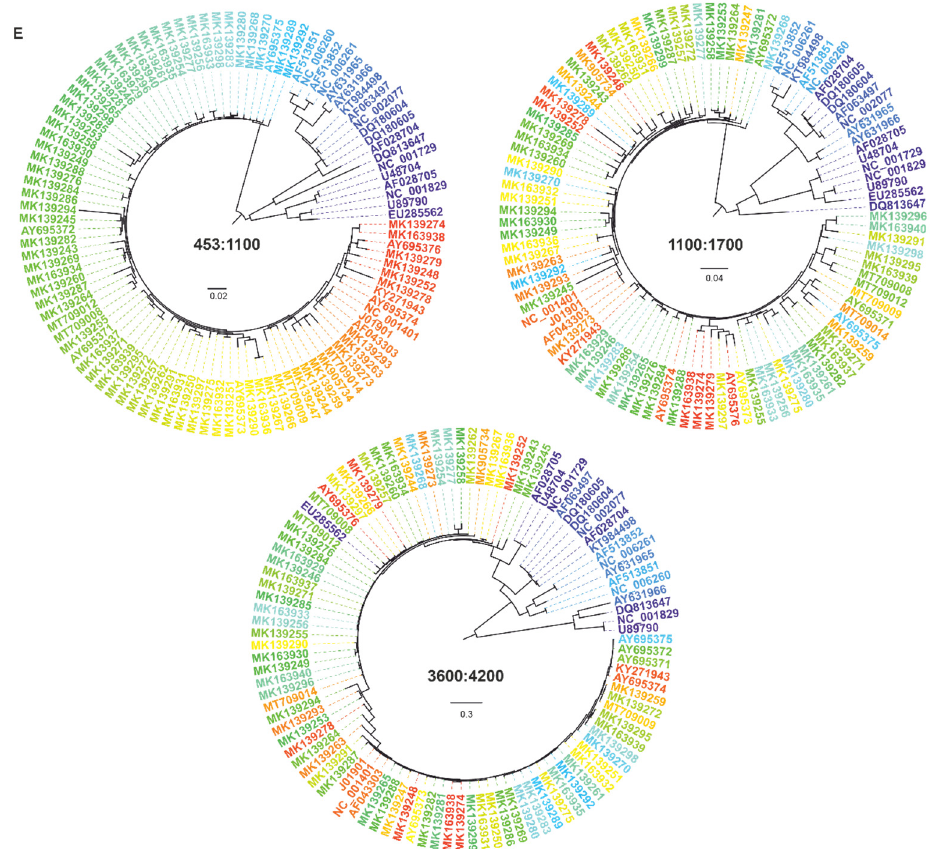
Figure 2. Pairwise nucleotide distance comparison plots (PDCP) indicate recombination between two genetic regions. Each dot corresponds to a pair of nucleotide distances between the same pair of genomes in two genomic regions (axis labels): ( A ) PDCP of even and odd sites in the 453–1700 nt frag- ment of AAV A alignment (negative control); ( B ) PDCP between VP1 and 3D regions of Enterovirus A species [45], a pattern typical to ubiquitous recombination (positive control); ( C ) PDCP between positions 453 to 1100 nt and 1100 to 1700 of AAV A alignment; ( D ) pairwise distance plot between positions 2600 to 3500 nt and 3500 to 4200 of AAV A alignment. The color indicates the density of overlapping values; ( E ) Phylogenetic trees for three regions in the AAV genome (453–1100; 1100–1700; 3600–4200). The colors of sequences match in trees for each genome region.